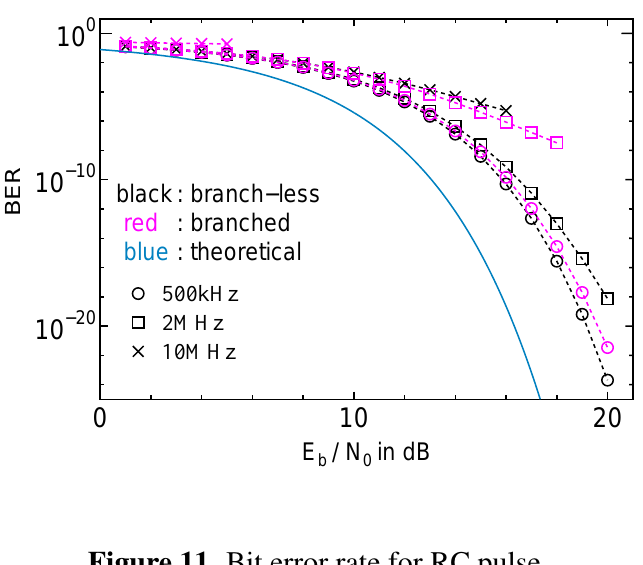
Figure 11. Bit error rate for RC